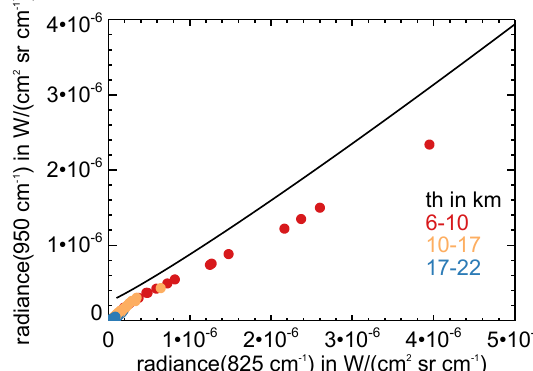
Figure 8. Simulation results for clear air at tangent heights (th) be- Fig. 8. Simulation results for clear air at tangent heights (th) be- tween 6 and 22km in polar winter, polar summer and mid-latitude tween 6 to 22km in polar winter, polar summer, and mid-latitude atmosphere and 10 and 22km in equatorial atmosphere. The black atmosphere. The black line denotes the ash detection threshold as line denotes the ash detection threshold as derived from measure- derived from measurements.